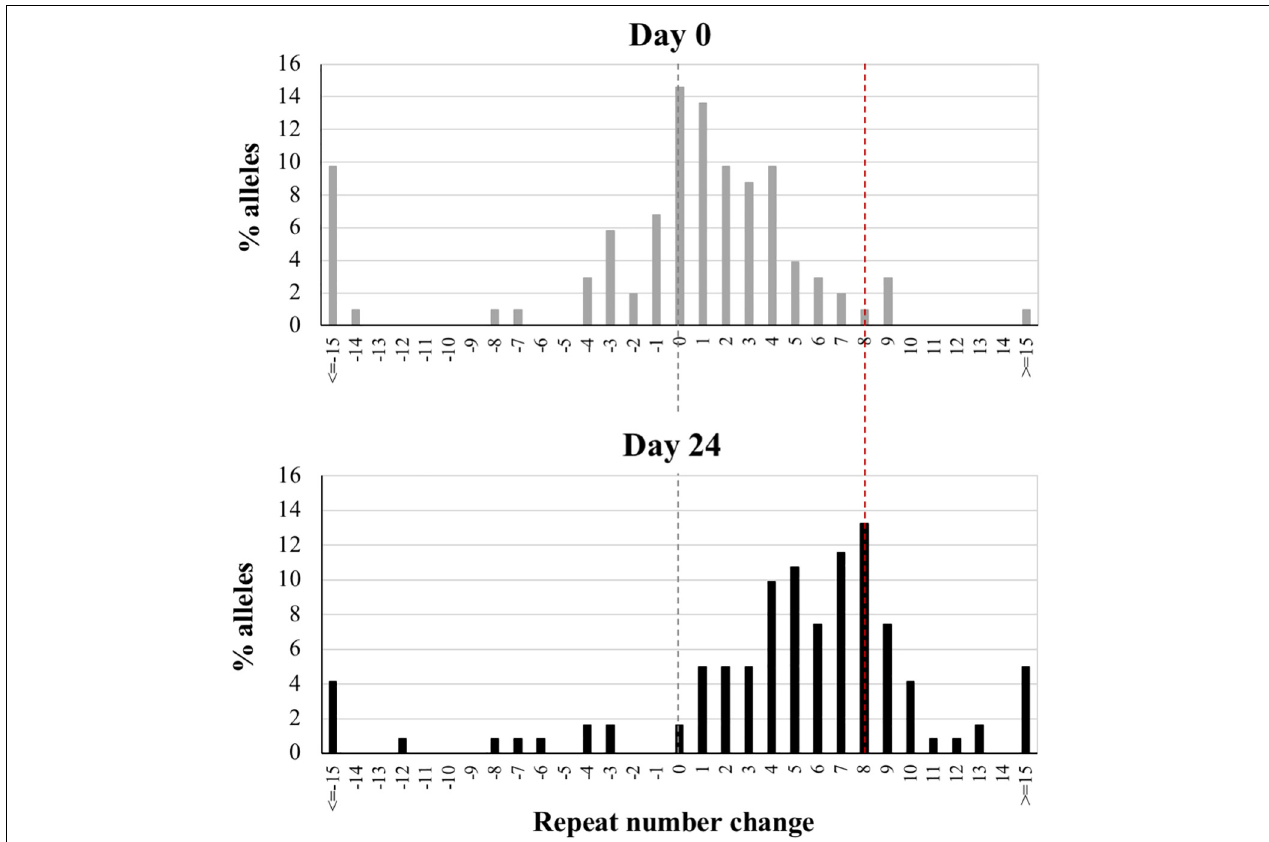
FIGURE 2 | Small pool PCR analysis of PM cell line showing the change in the distribution of alleles with time. Nested PCR on diluted DNA from a cell line carrying 175 repeats was performed at day 0 and day 24. The nested PCR results in a ∼ 3 repeat decrease in the average PCR product relative to the bulk DNA because of the bias generated by strand-slippage during the PCR reactions. Thus, the distributions were corrected accordingly and the major allele at day 0 was set at 0 with the remaining alleles shown as the change in repeat number relative to this allele. The black dotted line reflects the major allele in the starting population and the red dotted line the major allele in the sample at 24 days. More than 100 alleles were examined for each sample.